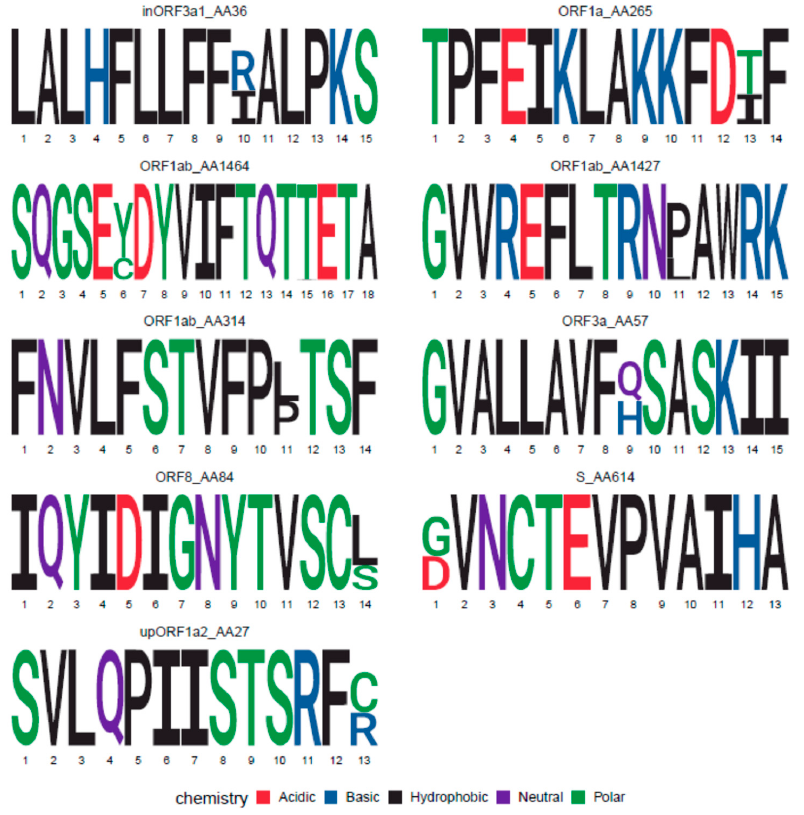
Figure 2. Sequence Logos for epitopes encompassing variable ( > 25%) positions. Protein location and starting amino acid positions are indicated on top of the logo.